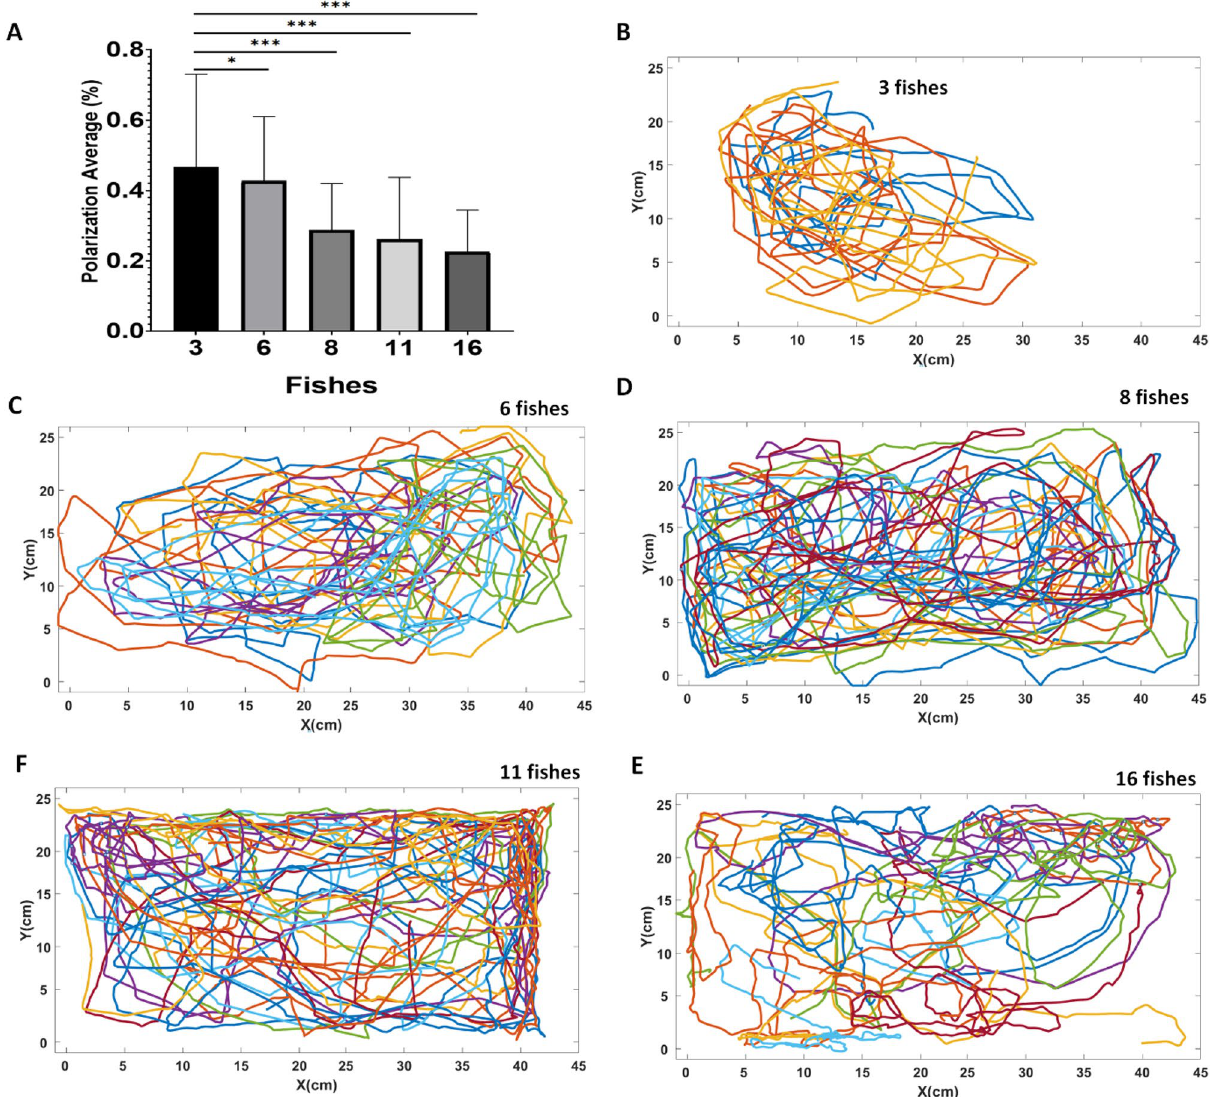
Figure 5. Polarization in groups (N = 3, 6, 8, 11 and 16 fishes) of different sizes of zebrafish. The horizontal lines of each group denote the mean ± SD and the asterisks on the brackets indicate statistical difference in comparison with the frequency of fish between the attempt and the control group by student t test (* p < 0.05; ** p < 0.001, *** p <